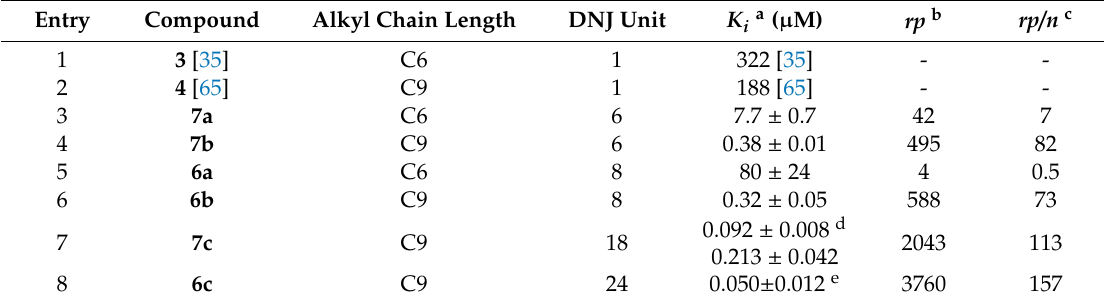
Table 1. Inhibition constants, relative inhibition potencies, and relative inhibition potencies per inhibitory unit of iminosugar clusters and monovalent references against JB α